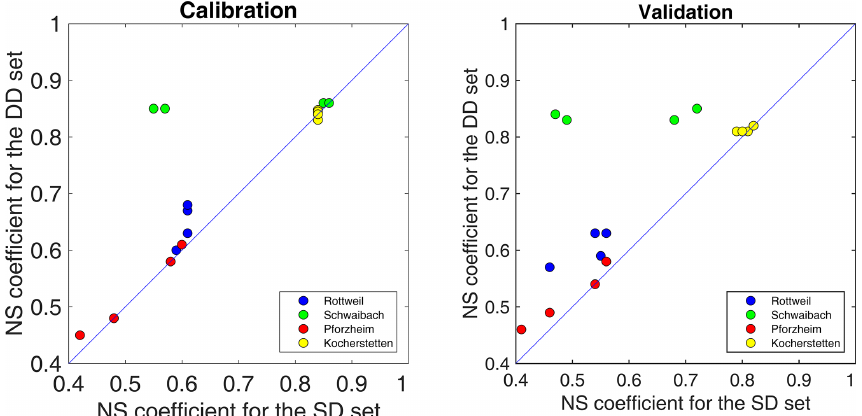
Figure 10. Comparison of the NS coefficient for different densities of raingauge networks; models were simulated based on daily time